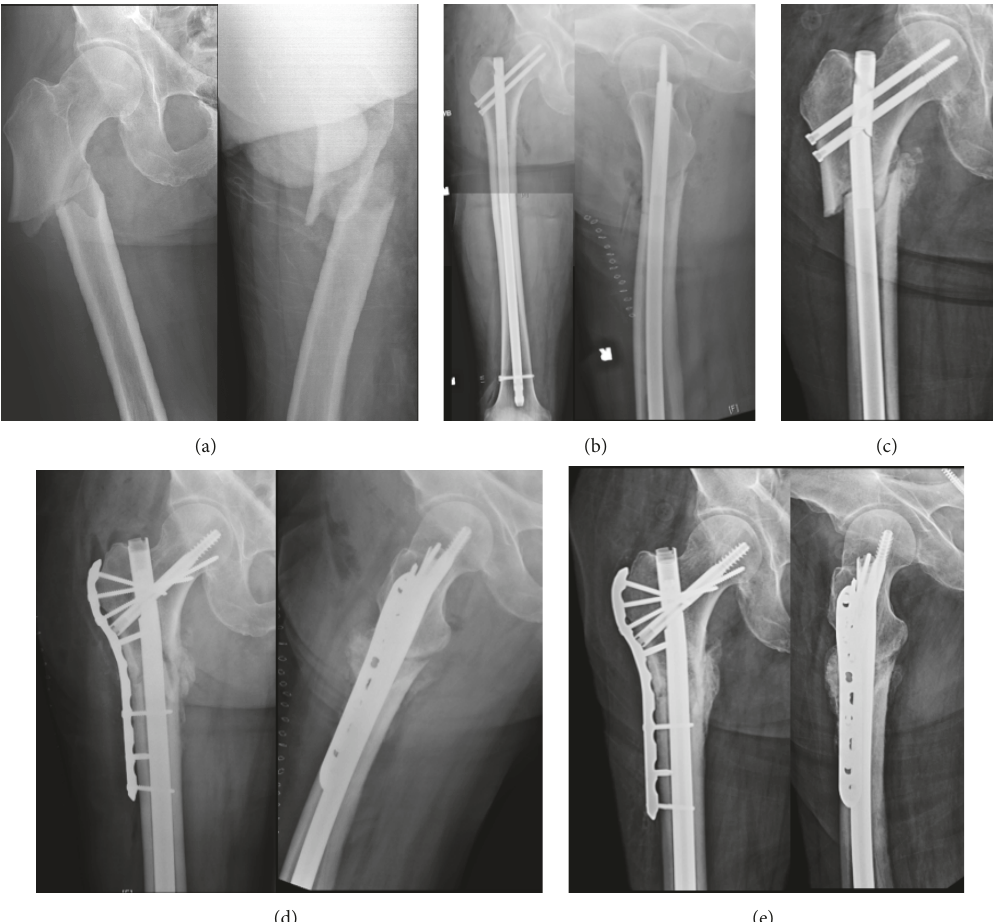
Figure 4: (a) Atypical right subtrochanteric femur fracture created in a 68-year-old male with 8-year history of bisphosphonate use. (b)